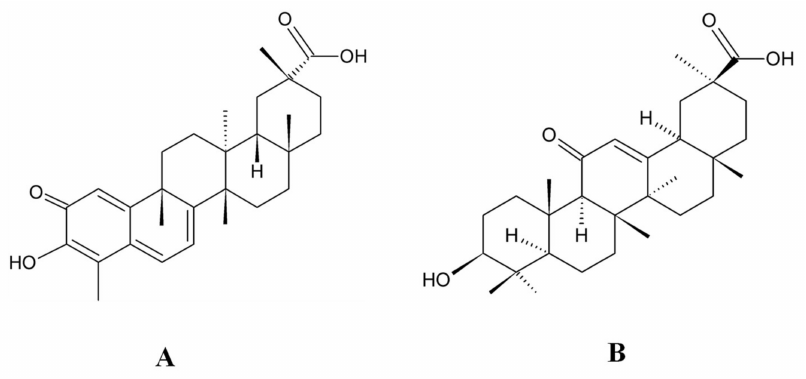
Figure 1. The chemical structure of celastrol ( A ) and 18- α glycyrrhetnic acid (IS) ( B